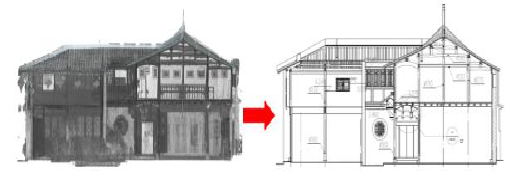
Figure 8 . Plane drawing